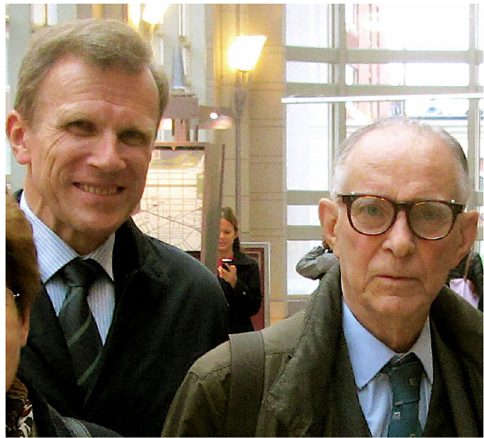
Fig. 1 Christian Pi fl and Oleh Hornykiewicz. Christian Pi fl and Oleh Hornykiewicz, 2014 in Boston on the occasion of the Warren Alpert Foundation Prize ceremony. Photograph by Stephan